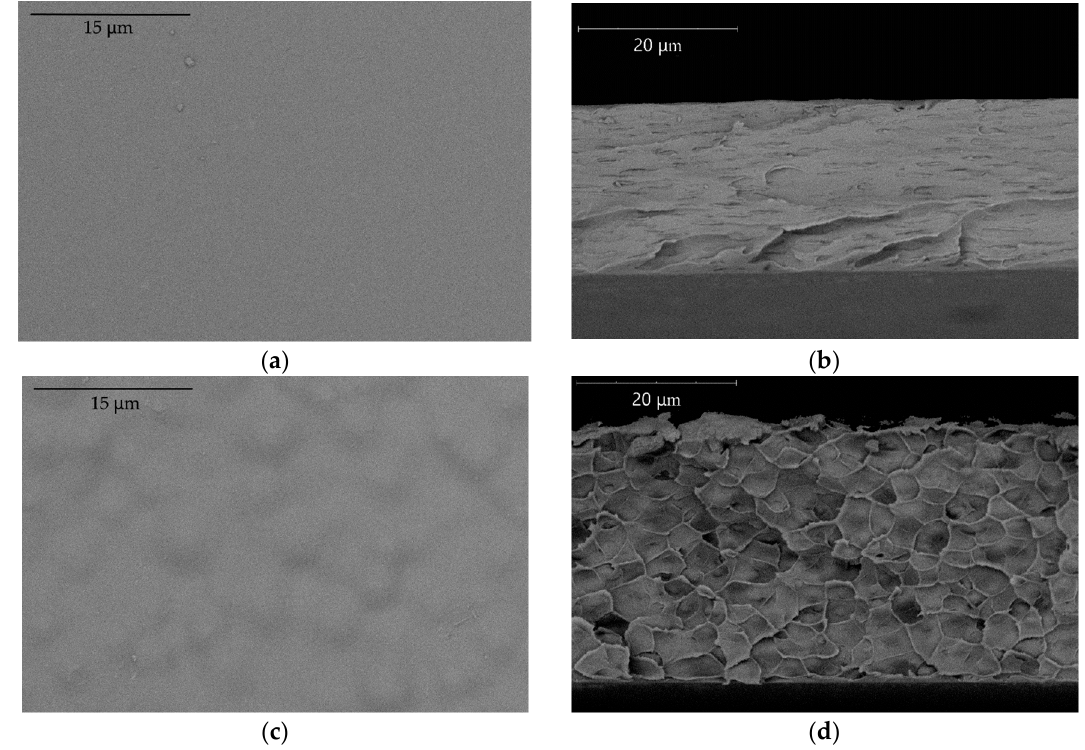
Figure 3. Micrograph of the surface ( a ) and cross ‐ section ( b ) of the blend #4 and the surface ( c ) and cross ‐ section ( d ) of the blend #5.